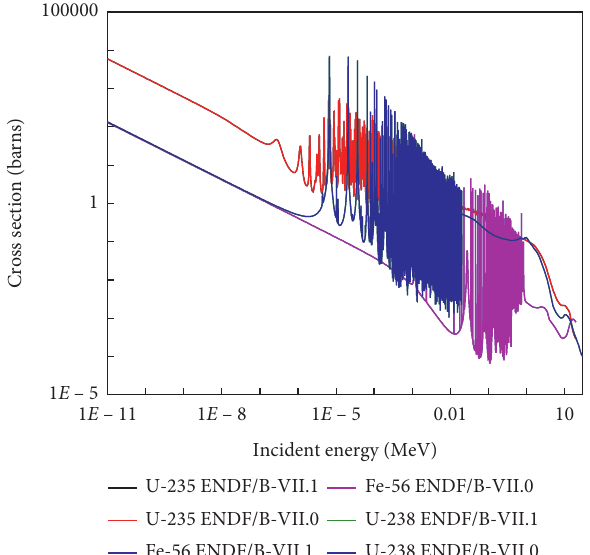
Figure 25: 56 Fe, 235 U, and 238 U capture cross sections of ENDF/B-VII.0 and